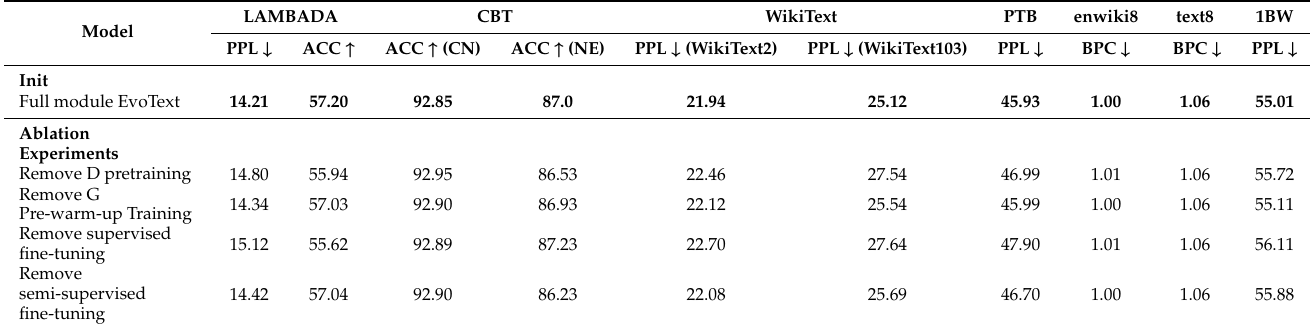
Table 10. We evaluated the impact of removing a particular module of EvoText GPT-2 media on ZERO-SHOT performance in seven